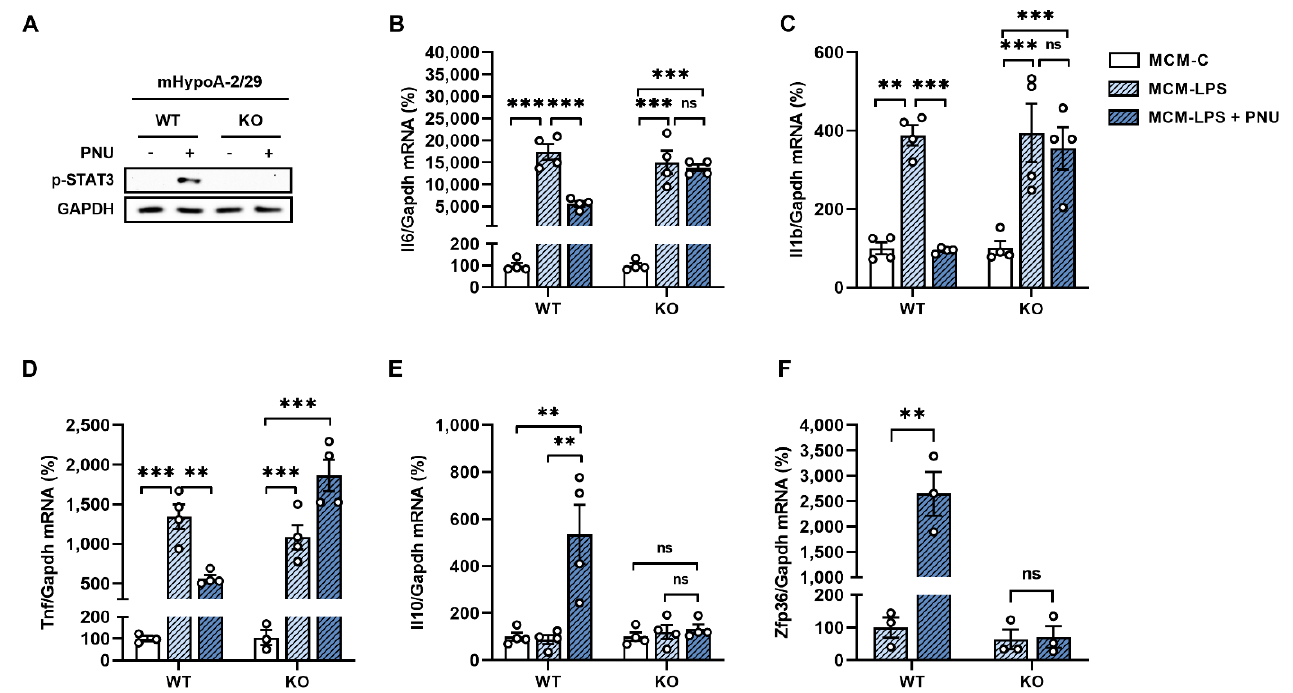
Figure 5. α 7nAchR knockout inhibits the effect of PNU-282987 to increase IL-10 and TTP expression Figure 5. α7nAchR knockout inhibits the effect of PNU -282987 to increase IL-10 and TTP expression in neurons. An α 7nAchR knockout mHypoA-2/29 cell line was established via CRISPR/Cas9. in neurons. An α7nAchR knockout mHypoA -2/29 cell line was established via CRISPR/Cas9. ( A ) ( A ) The functionality of the α 7nAchR receptor in WT and KO cells was evaluated by Western blot The functionality of the α7nAchR receptor in WT and KO cells was evaluated by Western blot based based on STAT3 phosphorylation levels after treatment with α 7nAchR selective agonist on STAT3 phosphorylation levels after treatment with α7nAchR selective agonist PNU -282987 (1 µM) for 15 min; ( B – F ) mHypoA-29 WT and KO cells were incubated with MCM-C or MCM-LPS for